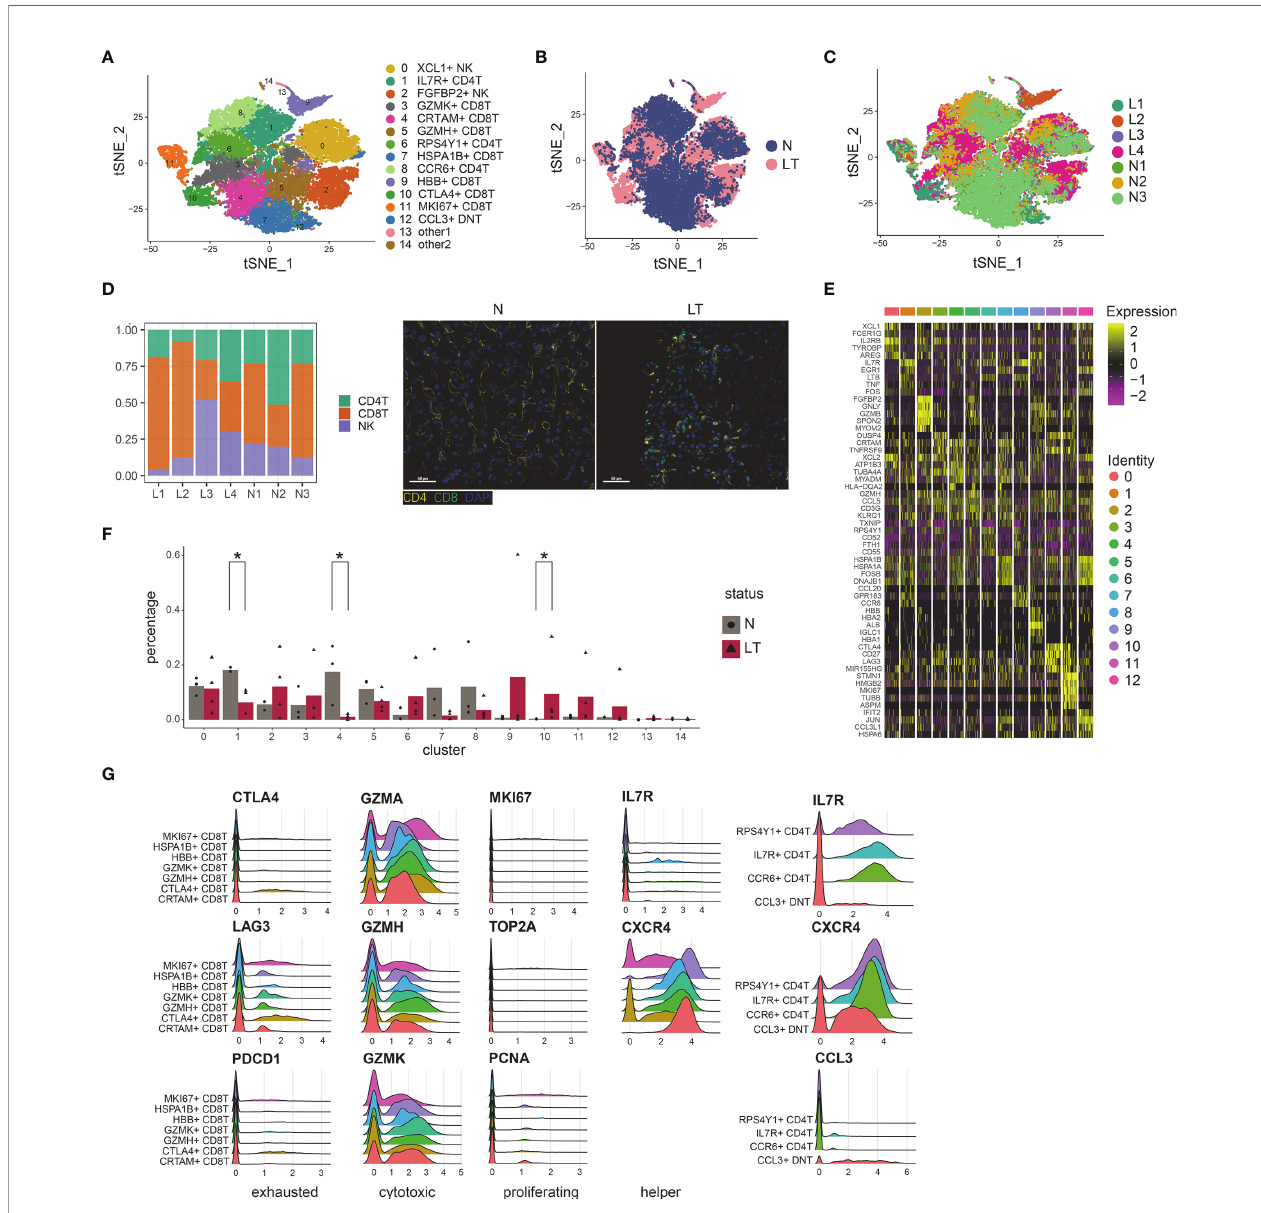
FIGURE 2 | Identifying T and NK cell subpopulations in liver tissue. (A) Clustering of 31,300 T and NK cells and cell annotation. (B) tSNE plot colors by spatial distribution of cells in normal (n=3) and liver transplantation (n=4) human tissues. (C) tSNE plot colors by spatial distribution of cells in 7 samples. (D) Barplots showing the proportion of CD4+ T cells, CD8+ T cells, and NK cells in each sample. Immuno fl uorescence including CD4 and CD8 in normal and liver transplantation. (E) Heatmap of each T and NK cells cluster top 5 marker genes. (F) Fractions of T, NK cell subpopulations in normal (n=3) and liver transplantation (n=4) samples (* means p < 0.05). (G) RidgePlots showing the expression of exhausted, cytotoxic, proliferating, and helper T cells of CD8+ T cells and CD4+ T